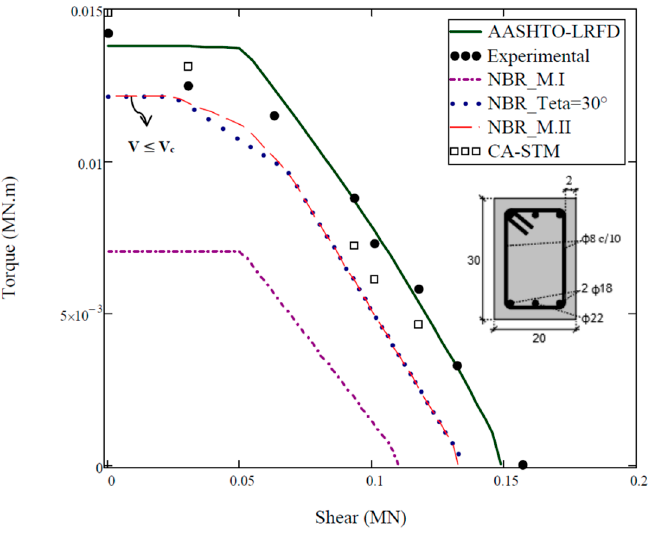
Figure 5. Interaction torque–shear curves for RC beams from Series 2.